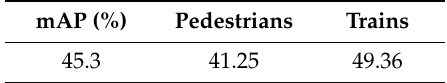
Table 6. Experiment results on the railway dataset.